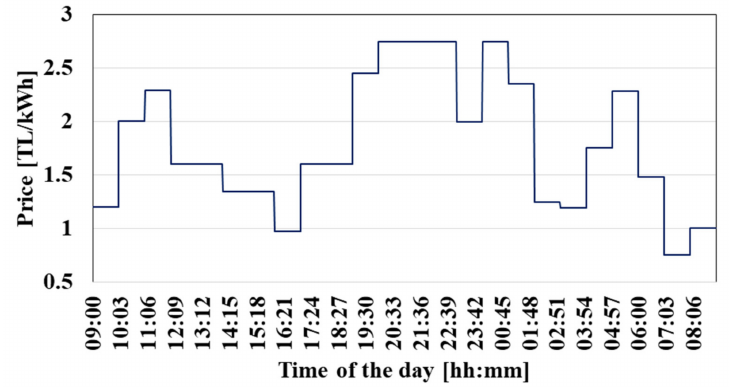
Figure 4. Electricity price